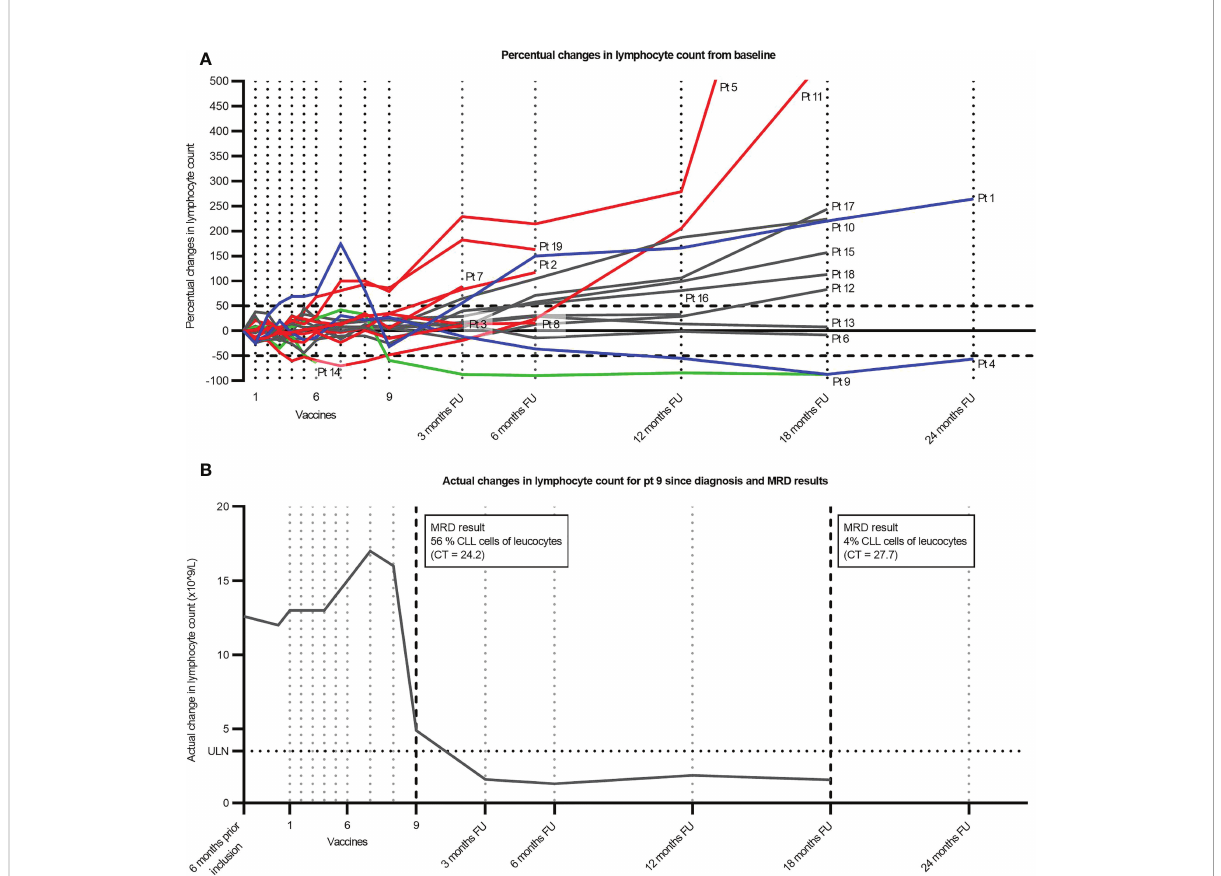
FIGURE 2 Lymphocyte count for individual patients over time. (A) Percentual changes in lymphocyte count from baseline. Red indicates patients who have started the next treatment, and the line indicates patients censored at the start of treatment. Blue indicates that the patient has been treated with steroids for periods during the depicted timespan. Green indicates patients achieving a 50% drop in lymphocyte count without subsequent progression or steroid treatment. The remaining patients are depicted in gray. (B) Actual changes in lymphocyte count for Pt9 since diagnosis. A percentual estimate of CLL cells of leucocytes in peripheral blood is indicated by the arrows based on qPCR results from the MRD assay. The fraction of CLL cells is calculated on basis of CT values from samples with different known CLL concentrations as described in the Supplementary Methods. FU, follow-up; ULN, upper limit of normal; CLL, chronic lymphocytic leukemia; MRD, minimal residual